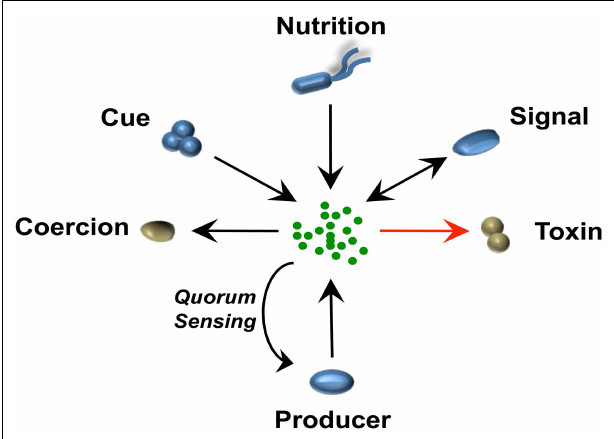
FIGURE 1 |A single chemical mediates different bacteria–bacteria interactions in a context of a polymicrobial community. The schematic represents how a single chemical released by one bacterial species can be perceived differently in a multispecies community. Microorganisms that benefit positively (blue) or negatively (brown) from the different interaction are represented. Arrows indicate direction of evolved pathway, e.g., an organism evolves to “sense” a cue or in some case can use an antibiotic as a nutritional source (Dantas etal., 2008). In the case of signaling and interspecies signaling, pathways from both producer and receiver cells have co-evolved to the benefit of both microorganisms. In the case of coercion or toxic interactions such as those exhibited by antibiotics, only the producer benefits from the interaction.When the producer itself detects the signal, this would be a case of quorum sensing or cell–cell signaling. In the case of antibiotics, the producer usually co-expresses resistance pathways and these can be co-expressed without a sensing circuit but often, such as with many lantibiotics, they are detected by the cell and respond in a classical quorum sensing feedback